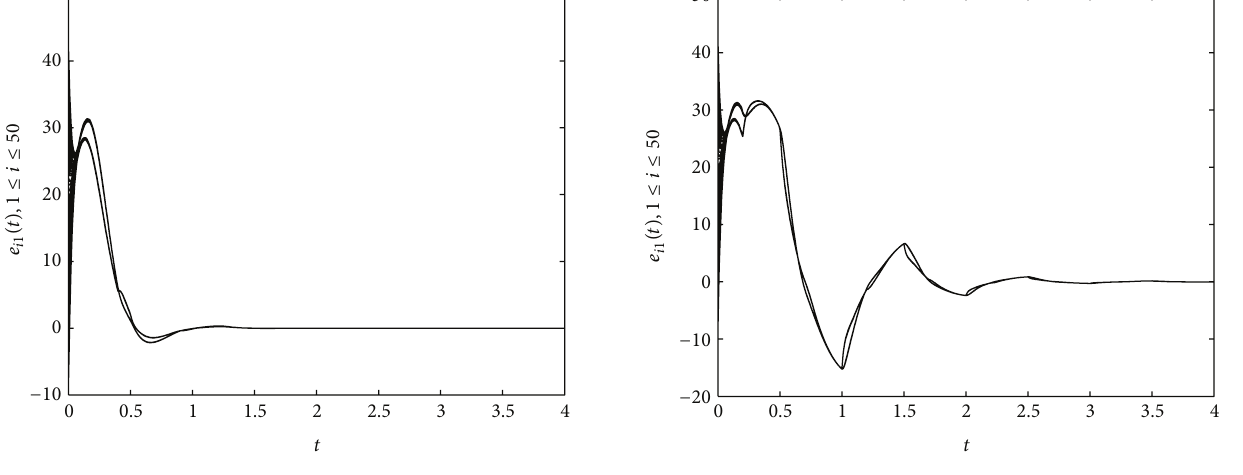
Figure 2: Synchronization errors 𝑒 𝑖 1 , 1 ≤ 𝑖 ≤ 50, with control parameters 𝑘 = 5, 𝑇 = 0 . 5, and 𝜃 = 0 . 8.